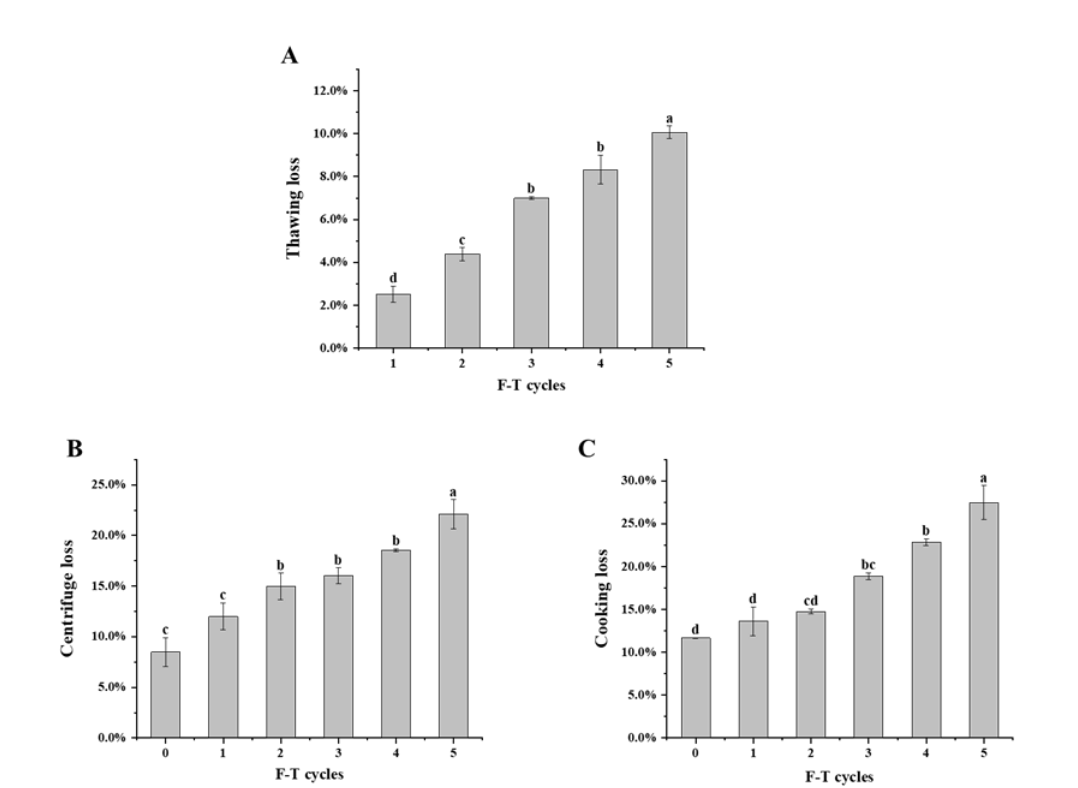
Figure 1. Thawing loss ( A ), centrifugal loss ( B ) and cooking loss ( C ) of cuttlefish after F-T cycles. Error bars show standard deviation. The letters “a–e” indicate significant differences ( p < 0.05).